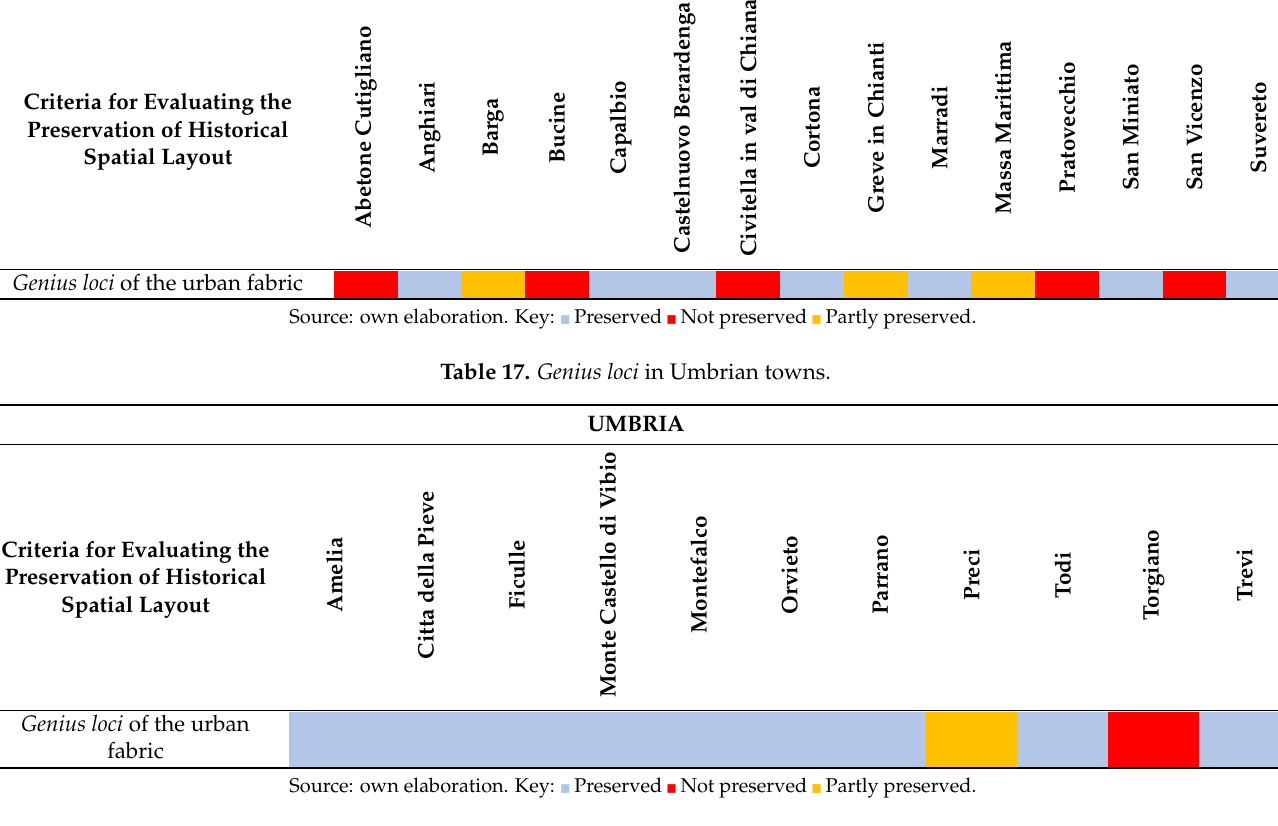
Table 18. Genius loci in Polish towns in the Region of Warmia and Mazury. WARMIA AND